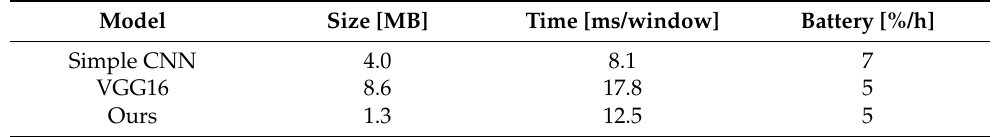
Table 7. Model size and performance on Apple